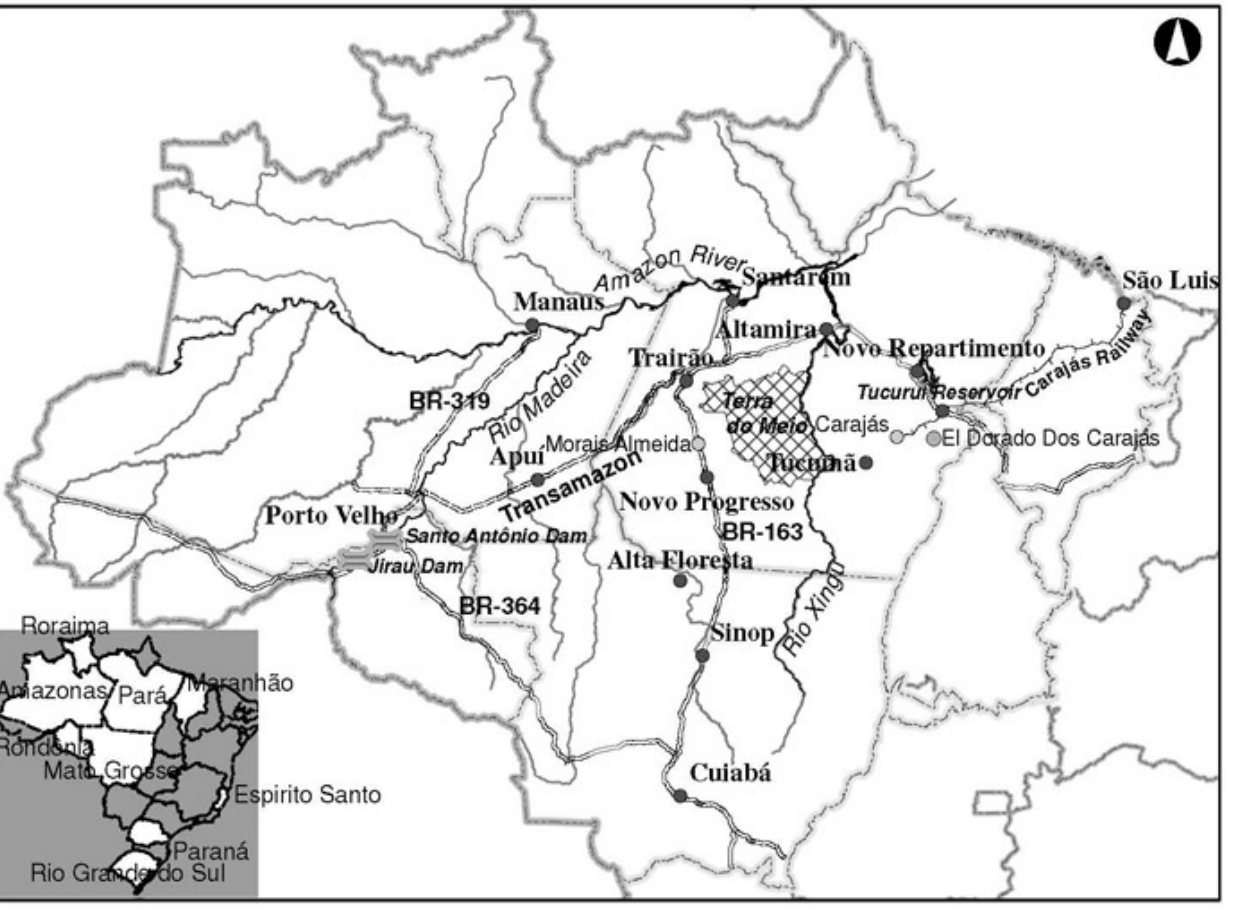
Fig. 1. Brazilian Amazonia with locations mentioned in the